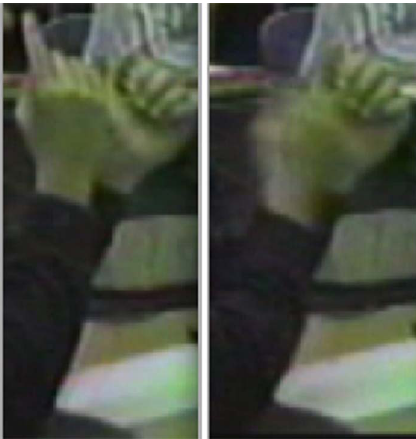
FIG. 7. (cid:1) Color (cid:2) Force-indicating gesture, “You’re just gonna (cid:3) G-F (cid:4) feel the forces being spun around … .” (cid:1) Student rapidly moves finger tip in horizontal circles.